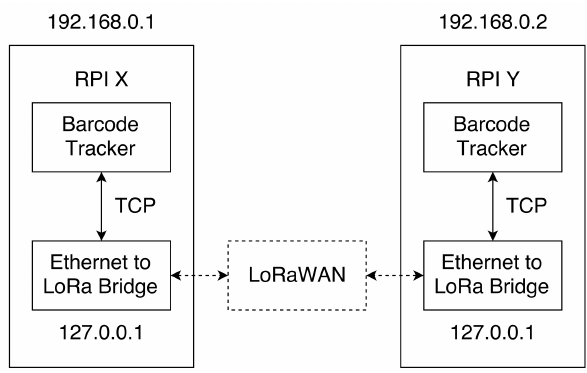
Figure 12. Communication mechanism between sensors over LoRaWAN.